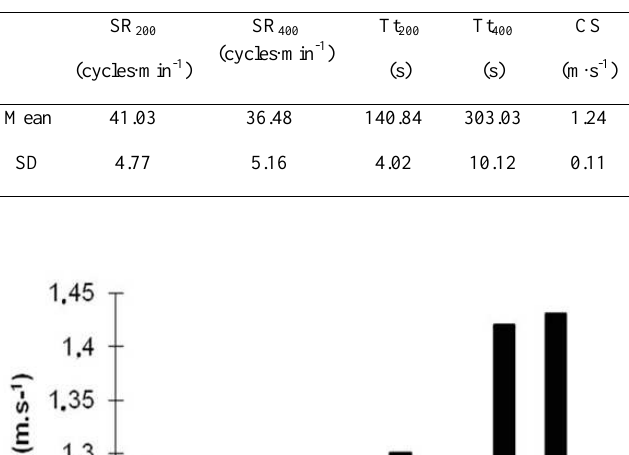
) Table 2. Comparison between mean stroke rate (SR) at prescribed 200 ) e 400 m (Tt ) and swimming velocity (PSV) and critical stroke rate (CSR). This table 200 400 shows corresponding SV to each PSV